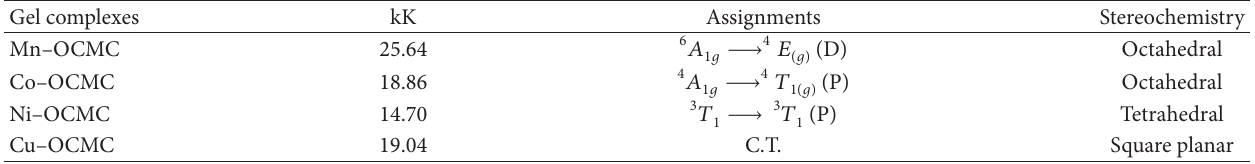
T 4: Electronic spectral assignments of OCMC Metallic Gel complexes.